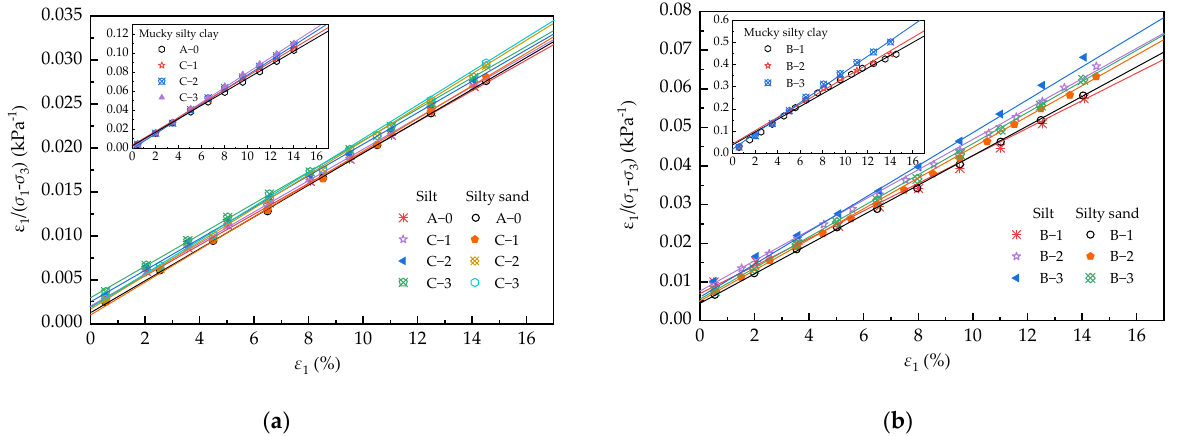
Figure 8. Normalized stress–strain curves under different stress paths. ( a ) Groups A and C; ( b ) Group B. Table 6. Normalized parameters under different stress paths.